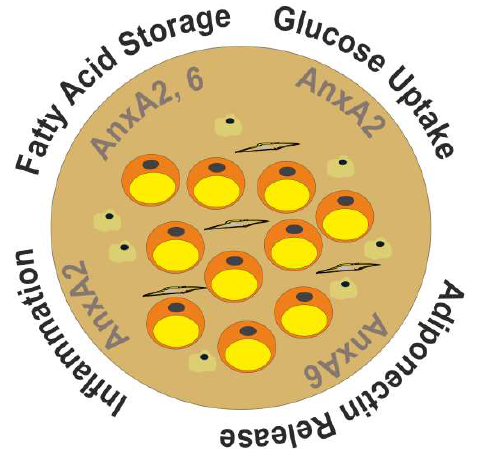
Figure 2. The diverse roles of AnxA2 and AnxA6 in adipose tissue function. AnxA2 improves uptake and storage of fatty acids [57] and may have a role in glucose uptake and adipose tissue inflammation [51,59]. On the other hand, AnxA6 modulates lipolysis and adiponectin secretion [68].